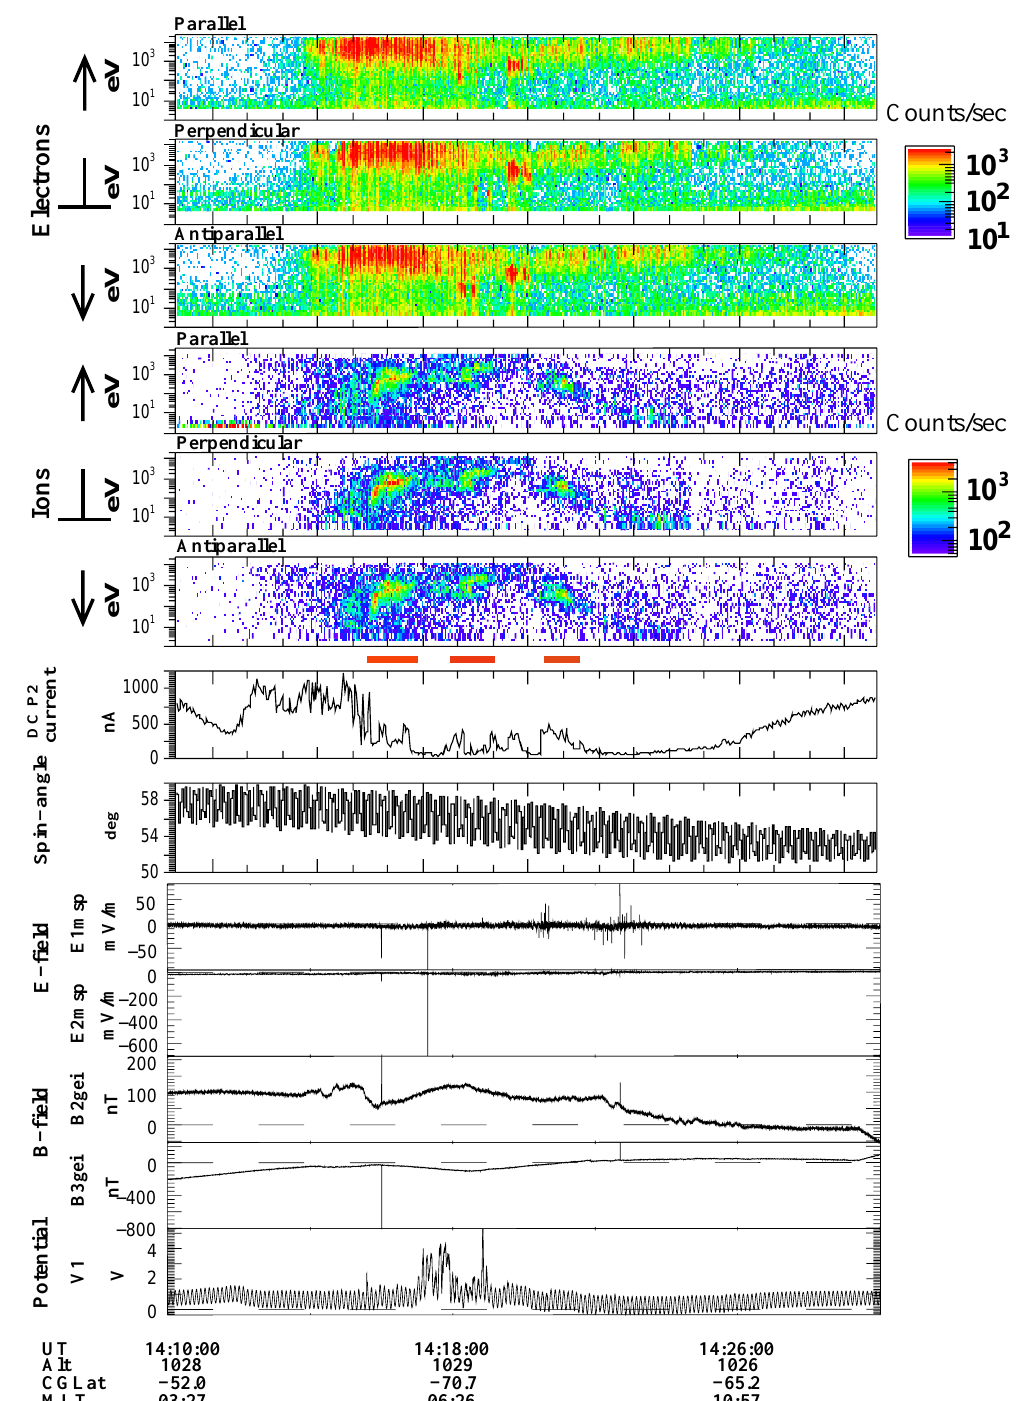
Fig. 1. Astrid-2 data for 3 July 1999 on the southern hemisphere. Distinct ion clouds (as marked by red lines) are observed. Note that only the first ion cloud is observed inside the CPS region. The other two ion clouds are not included in this study, as explained in the text. From top to bottom, three panels of data (counts/s) from the electron detectors that are most parallel (upper), most perpendicular (middle) and most anti-parallel (lower) to the geomagnetic field; three panels of data from the ion detectors (same order as for electrons); the plasma density measured as the current into the Langmuir probe; the angle between the spin-axis and the magnetic field; two panels of electric field (E1msp is the electric field component in the spin plane along the projection of model B, E2msp is the electric field component perpendicular to both E1msp and the spin axis); two panels of magnetic field (B3gei is the magnetic field component along Earth’s (north) rotation axis, B2gei is the magnetic field component perpendicular to both B3gei and the direction toward vernal equinox point); and the probe potential at one of the electric field